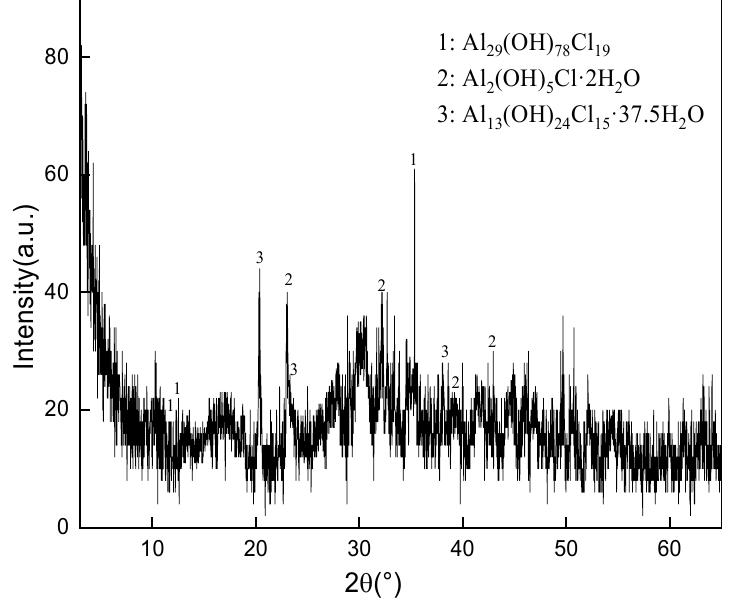
Figure 10. XRD patterns of the product.